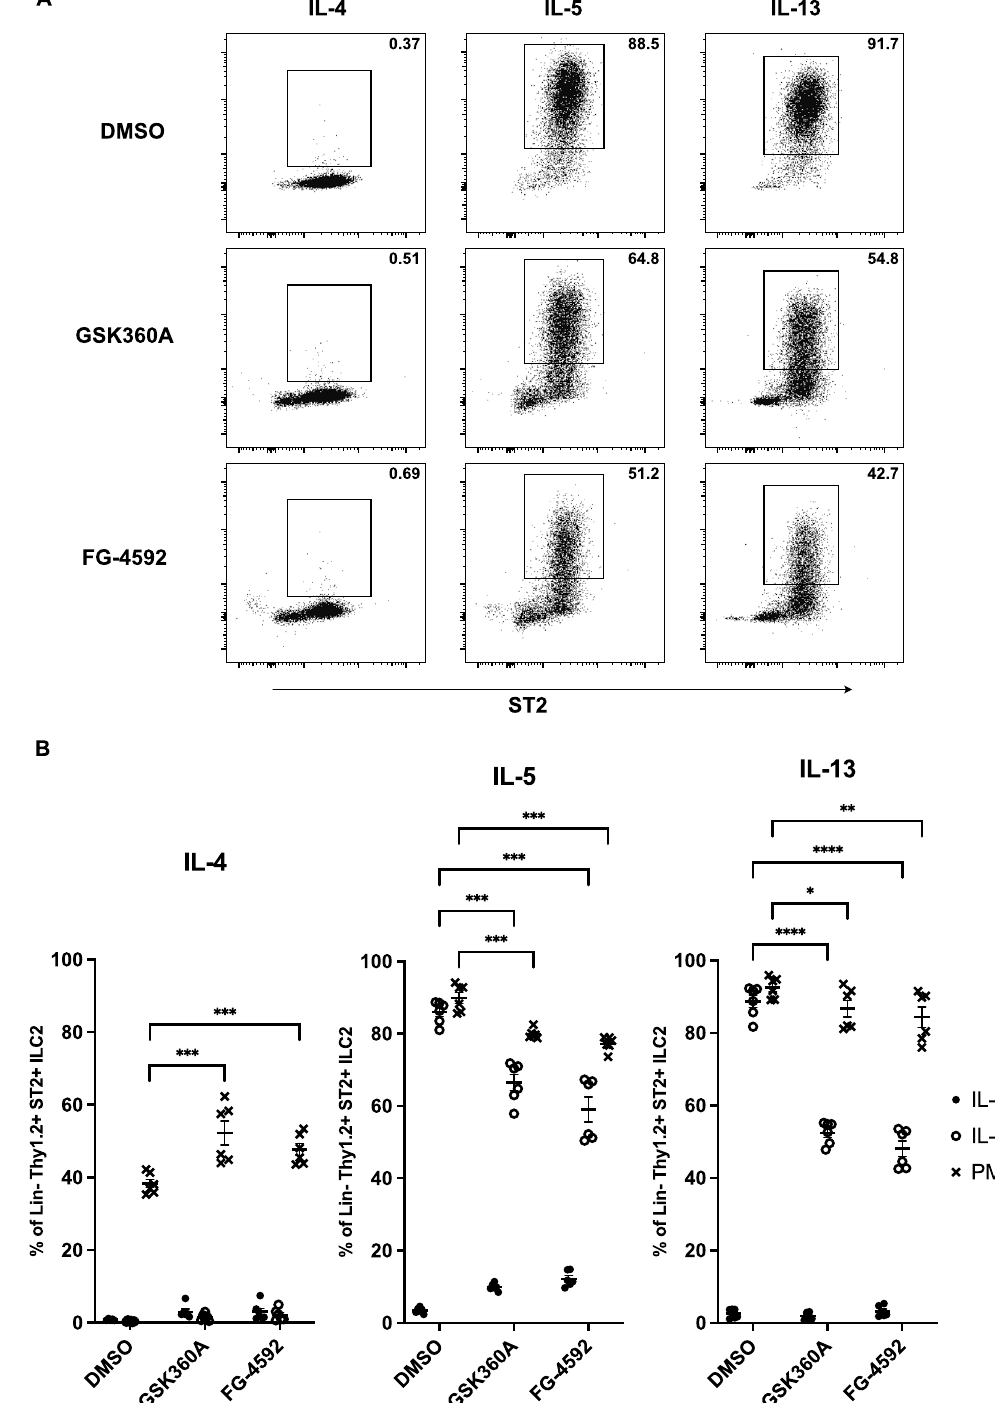
Figure 2. HIF-PHD inhibitors suppressed the production of IL-5 and IL-13 from kidney ILC2s in vitro. ILC2s were sorted from kidneys of pooled 6 mice, and cultured with IL-2 and IL-7 for 3 days. Half of the media were subsequently changed with fresh media containing IL-2 and IL-7. After another 3 days of culture, ILC2s were stimulated by 50 ng/ml recombinant murine IL-33 or 50 ng/ml PMA and 500 ng/ml ionomycin for 3 h in the presence of brefeldin A. ( A ) Representative plot of intracellular cytokine staining for IL-4, IL-5, and IL-13 in kidney ILC2s stimulated by IL-2/7/33. ( B ) The graph shows the frequency of IL-4, IL-5, and IL-13 in kidney ILC2s. We used the pooled kidney from 6 mice as n = 1, and data shown are pooled from two (n = 6) independent experiments. Error bars show SEM. * p < 0.05, ** p < 0.01, ***p <